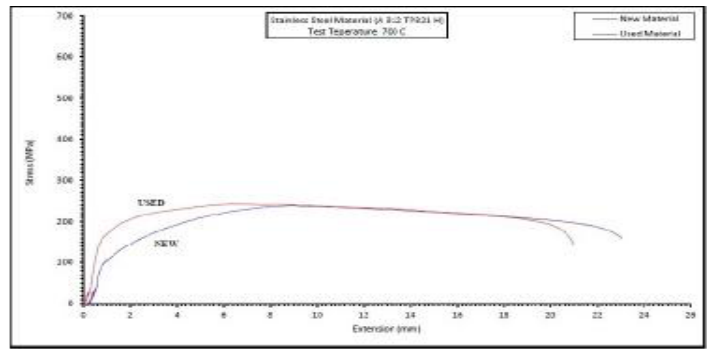
Fig. 12 Stress-strain curve at 700 o C temperature for un-used and ex-used stainless steel